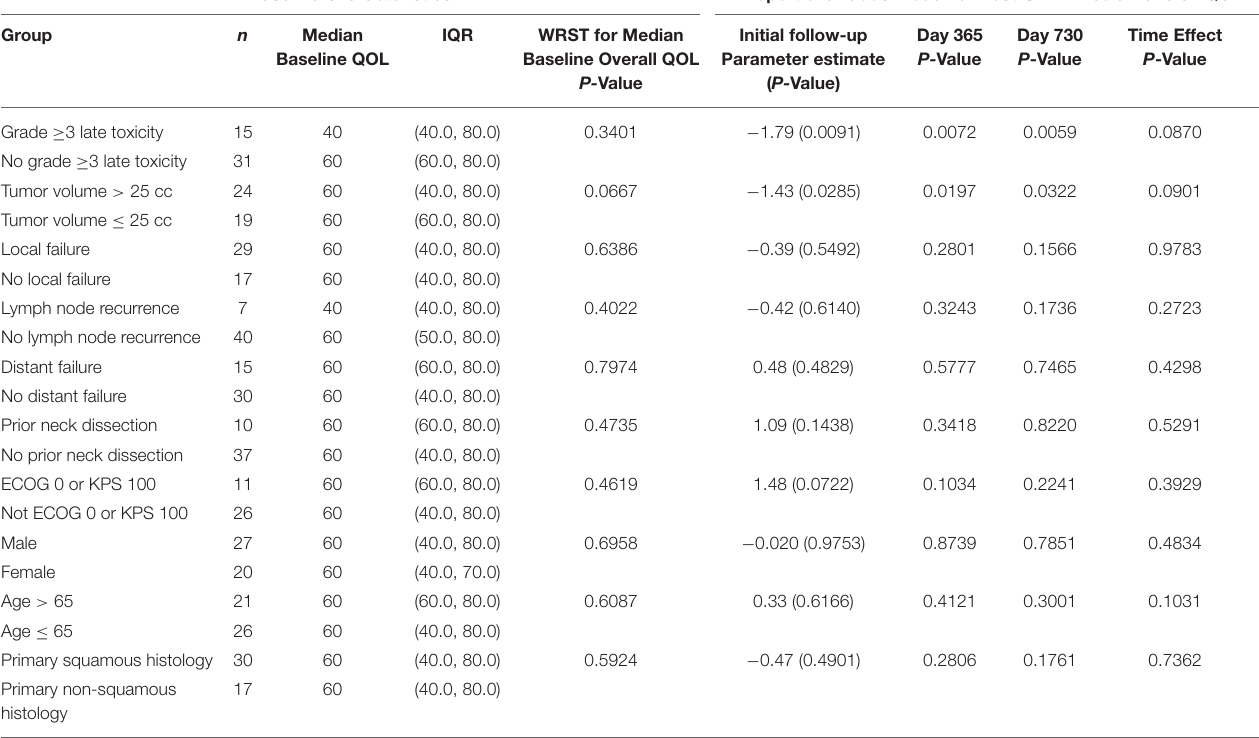
TABLE 2 | Effects of patient variables on overall QOL